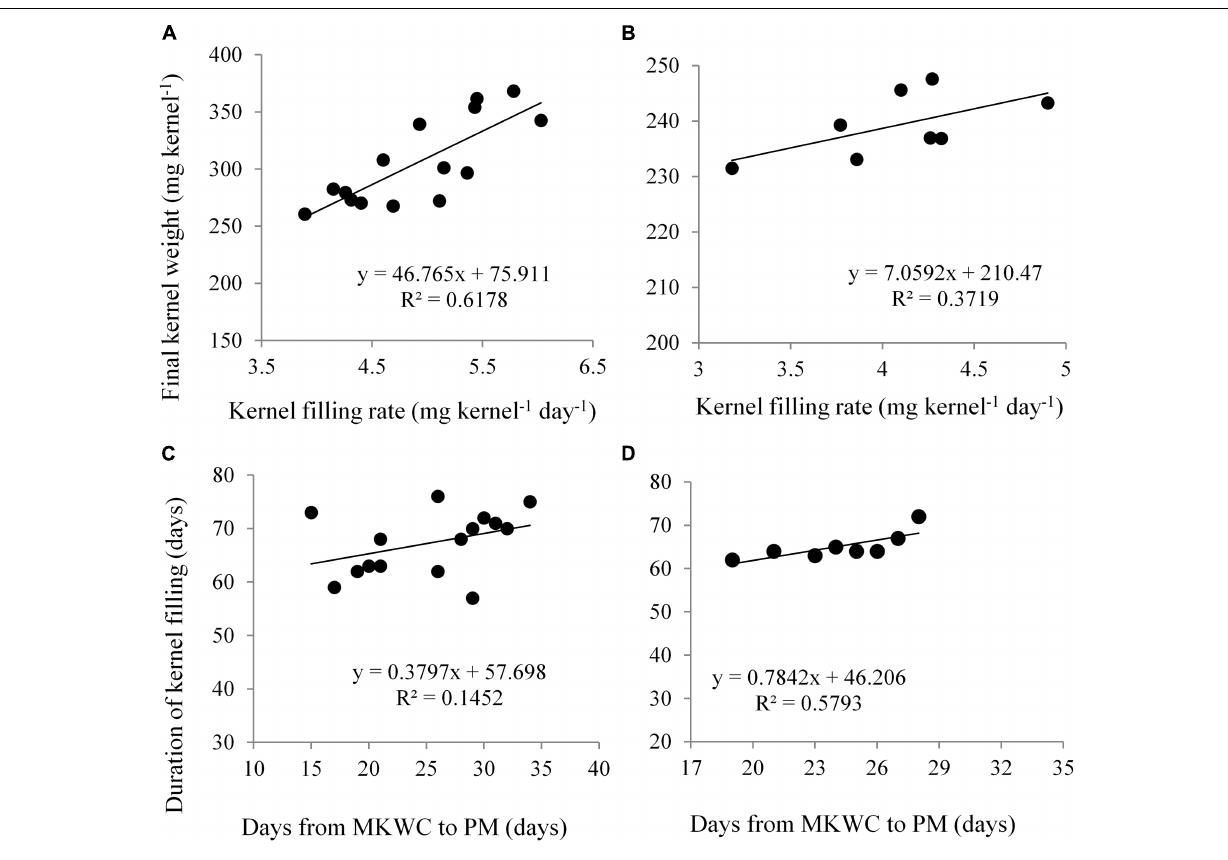
FIGURE 8 | Relationship between kernel filling rate and final kernel weight in Expt. 1 (A) and Expt. 2 (B) ; days from maximum kernel water content (MKWC) to physiological maturity (PM) and duration of kernel filling in Expt. 1 (C) and Expt. 2 (D)